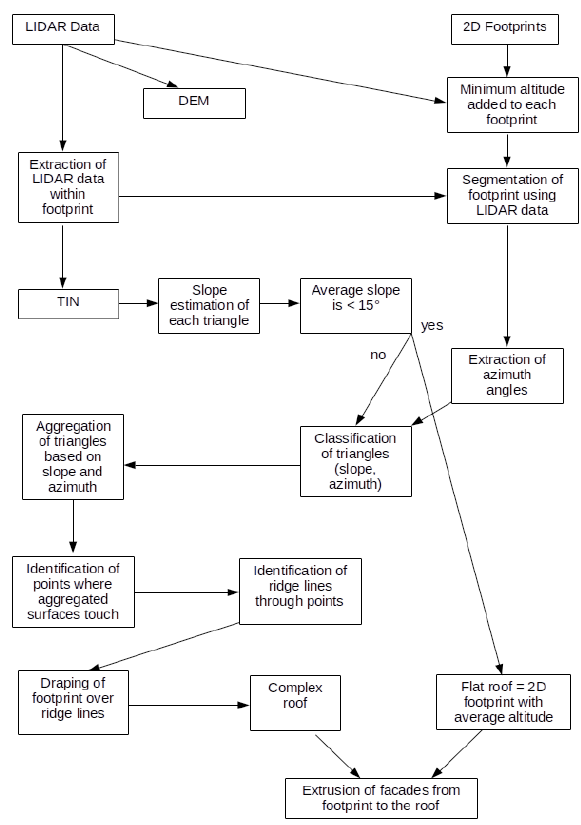
Figure 5. Processing schema. The input data is a LIDAR point cloud and 2D footprints derived from the cadastre. The output is a DEM (raster) as well as building roofs and facades